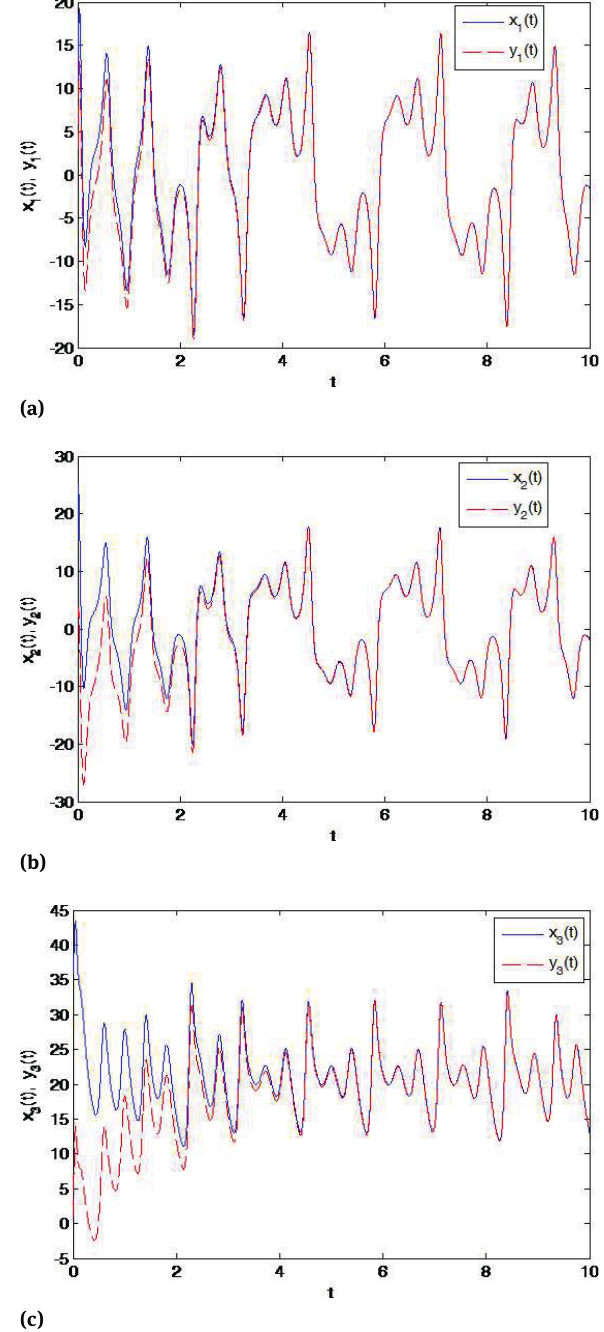
Fig. 3: State trajectories of drive system (1) and response system (3) for fractional order q = 0.96 , (a) between x 1 and y 1 , (b) between x 2 and y 2 , (c) between x 3 and y 3 using active control